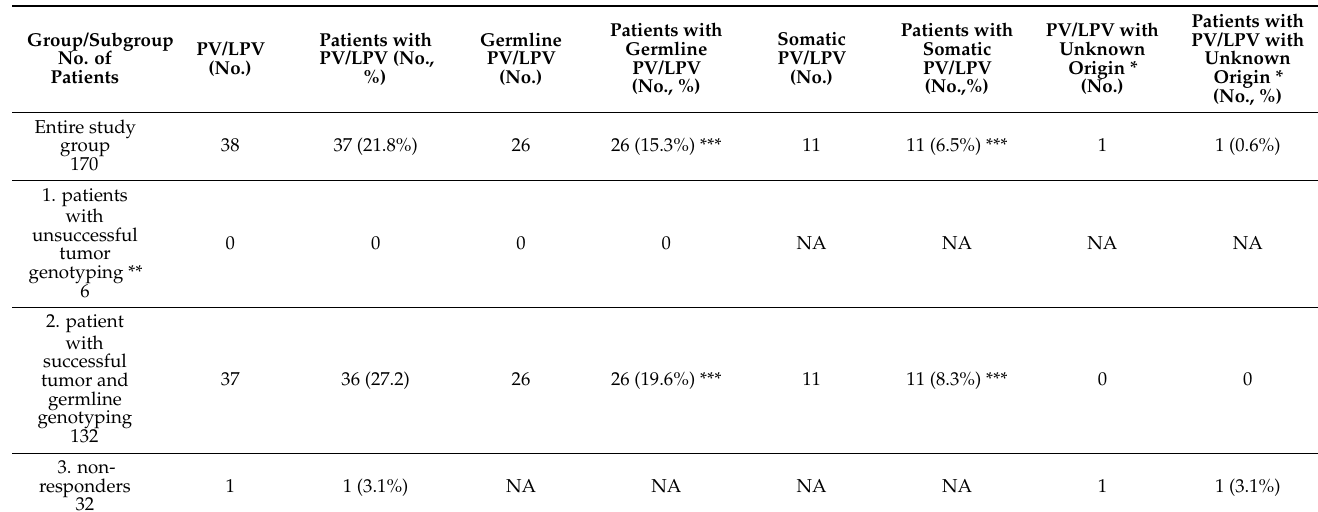
Table 2. Pathogenic/likely pathogenic variants (PV/LPV) in BRCA genes among all 170 consecutive advanced non-mucinous EOC